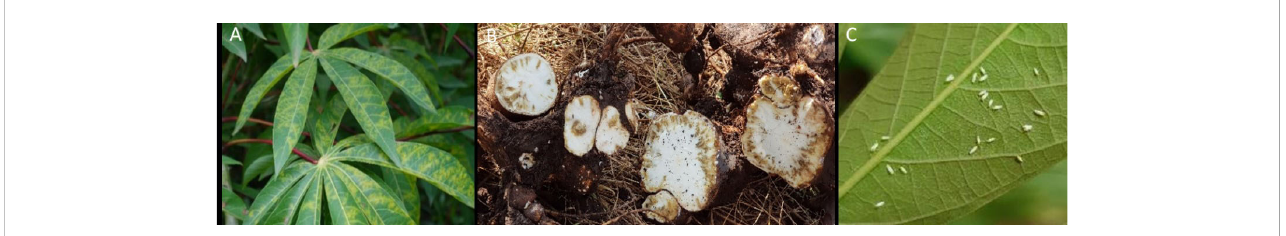
FIGURE 2 Vein chlorosis, and yellow blotches on leaves (A) , severe necrosis symptoms on tuberous roots (B) from CBSD on a sensitive cassava variety. Symptoms are mostly visible on older leaves and on tuberous roots reaching maturity. Semi-persistent virus transmission by the vector (B) tabaci (C) depends on high numbers of adult